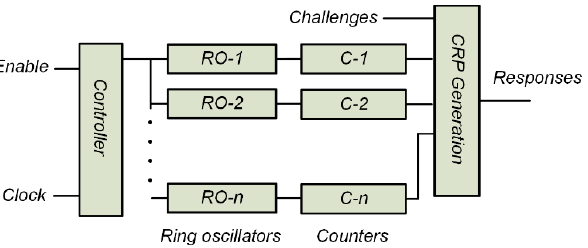
Figure 1. The proposed uniform RO-PUF.